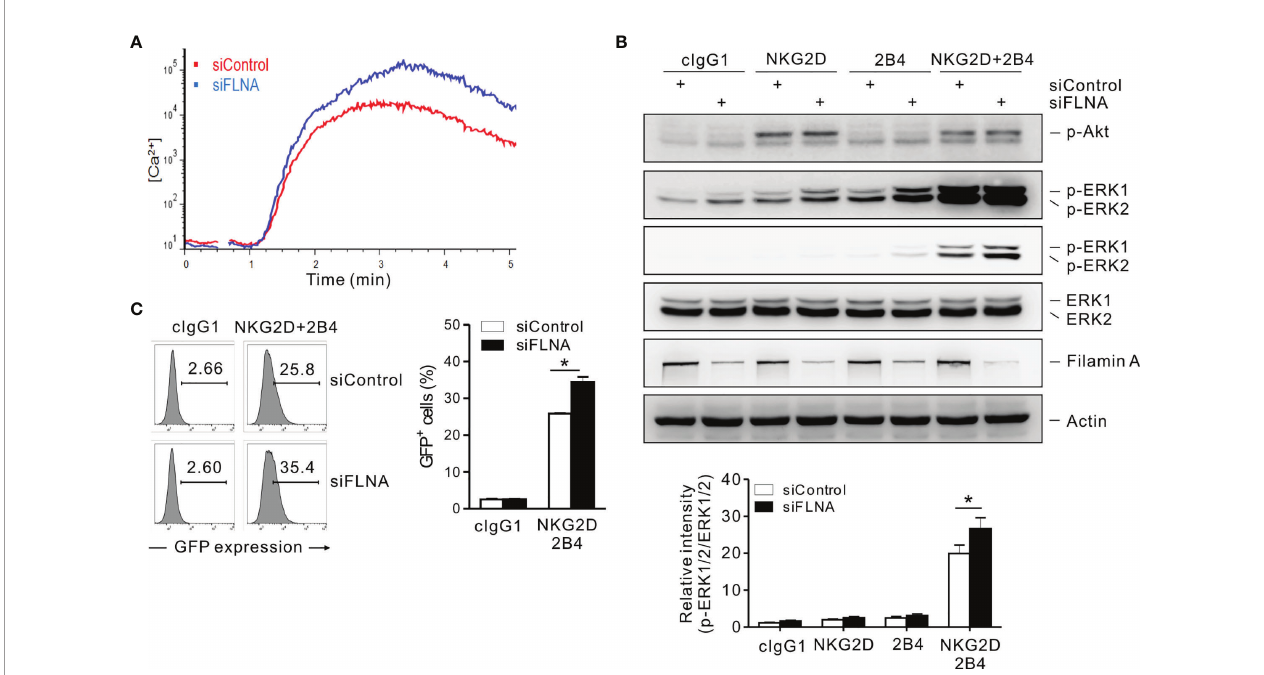
FIGURE 7 | An FLNa knockdown potentiates both calcium-mediated signaling and NF- k B activity. (A) Rested NKL cells nucleofected with control or FLNa-speci fi c siRNAs were labeled with Fluo-4 for 30 min at 30°C and stimulated via NKG2D and 2B4 after measuring the baseline Ca 2+ fl ux for 30 s. Ca 2+ mobilization-mediated changes in fl uorescence are shown as a function of time. (B) Rested NKL cells nucleofected with control or FLNA-speci fi c siRNAs were preincubated with an isotype control or with speci fi c mAbs to NKG2D and/or 2B4 and stimulated by receptor crosslinking for 2 min. Lysates were subject to immunoblotting for p-Akt, p-ERK1/2, ERK1/2, FLNa, and actin ( top ). Band intensities of phosphorylated ERK1/2 relative to total ERK1/2 were quanti fi ed using ImageJ software and are presented ( bottom ). (C) Rested NKL cells transduced with a k B reporter construct were stimulated with plate-immobilized mAbs against NKG2D and 2B4 for 6 h. GFP expression in NKL- k B-GFP cells was analyzed by fl ow cytometry, and representative results ( left ) and a summary graph ( right ) are shown. Error bars represent the SD; * P < 0.05. Data are representative of three independent